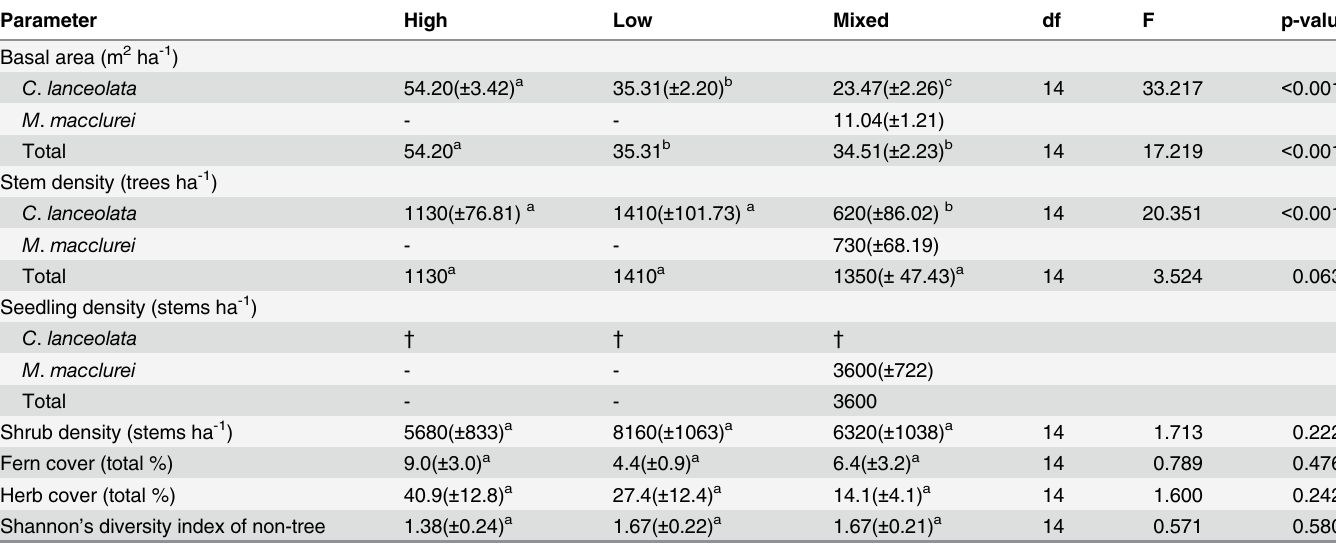
Table 3. Structural traits (means ± SE) of the stands (n = 5 plots per stand) at Huitong. Parameter